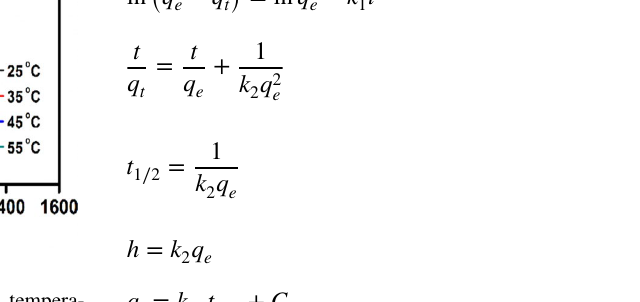
Fig. 4 The exchange of adsorption kinetics with a various tempera- ture of solution